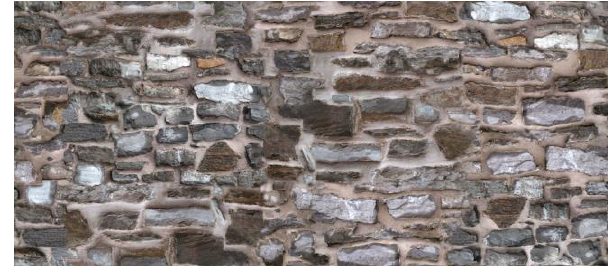
Figure 3: A classic sample of stitched textures for the fort’s curtain wall done in Photoshop.